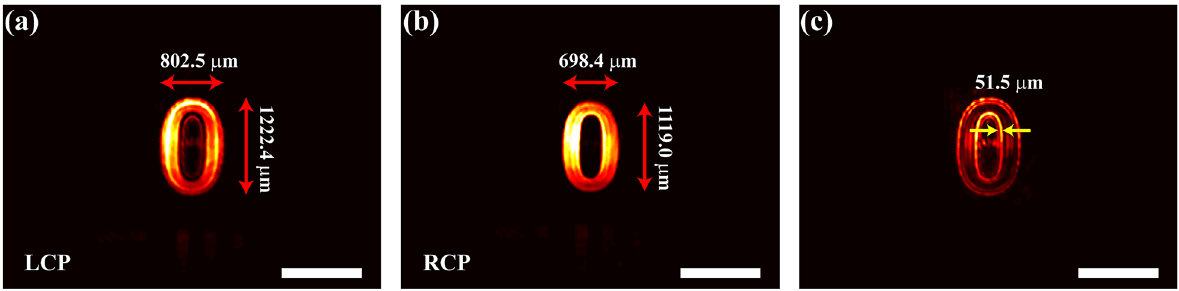
Figure 5: Experimental demonstration of 2D edge detection by